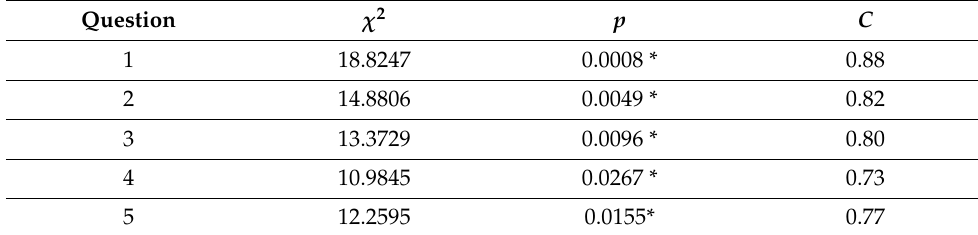
Table 3. Results of the χ 2 test.